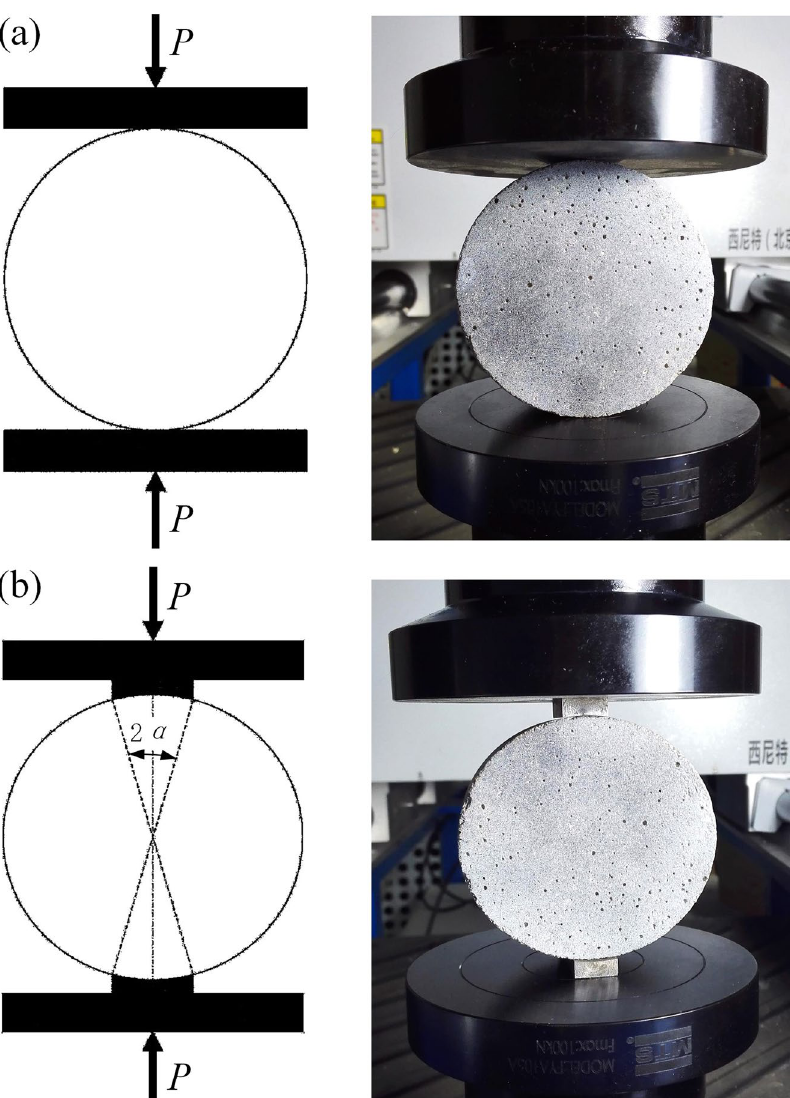
Figure 2. Illustration and photograph of two loading methods: ( a ) concentrated line loading and ( b ) 20° arc loading with bearing